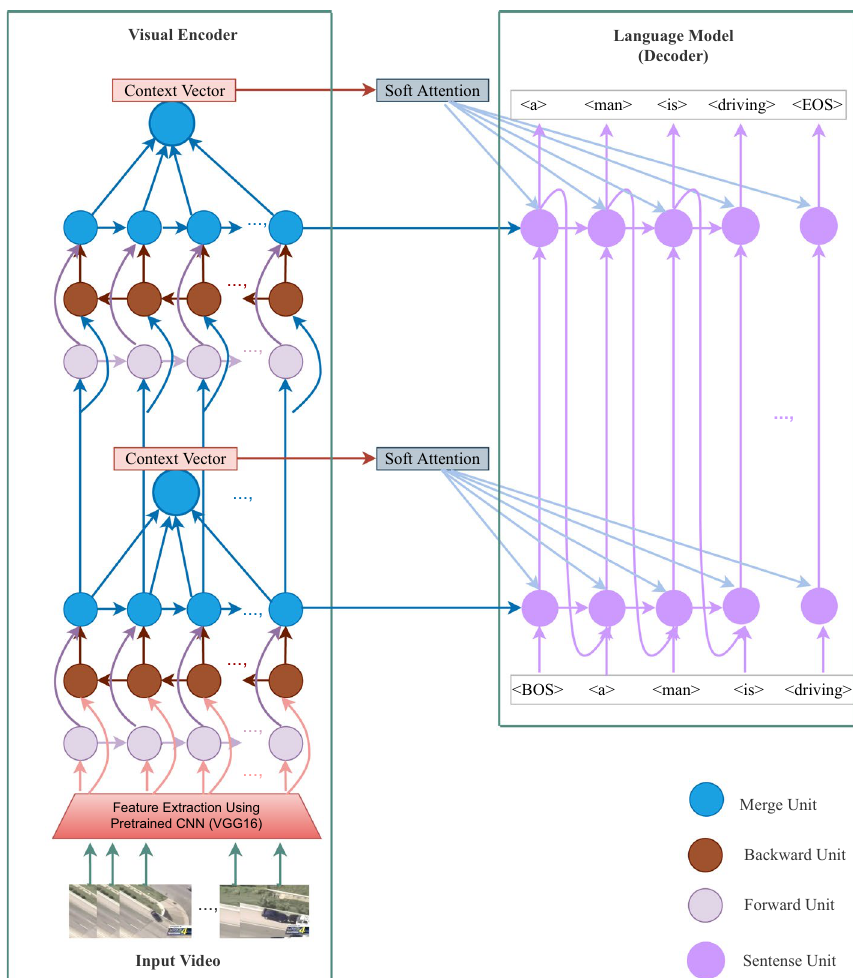
Fig. 4 Proposed Multi-Layer Attention